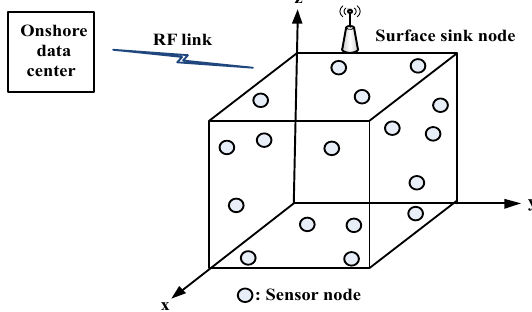
Figure 1. Sketch of the proposed network